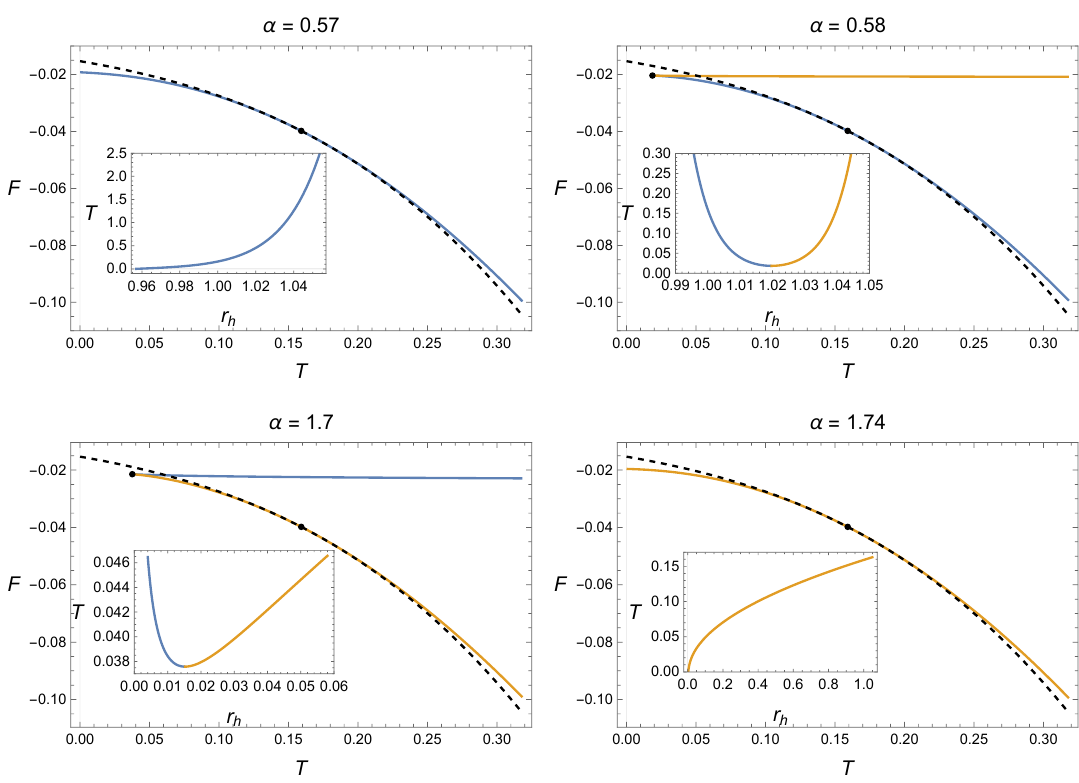
Figure 1 . The free energy as a function of temperature for different values of α . The dashed line is for the SAdS black hole, while the solid line is for the hairy black hole, where the blue one is for r h, + and the orange one is for r h, − . The subfigure describes the relation between the temperature and horizon radius. In all figures, we have set L = G = V = 1 Σ